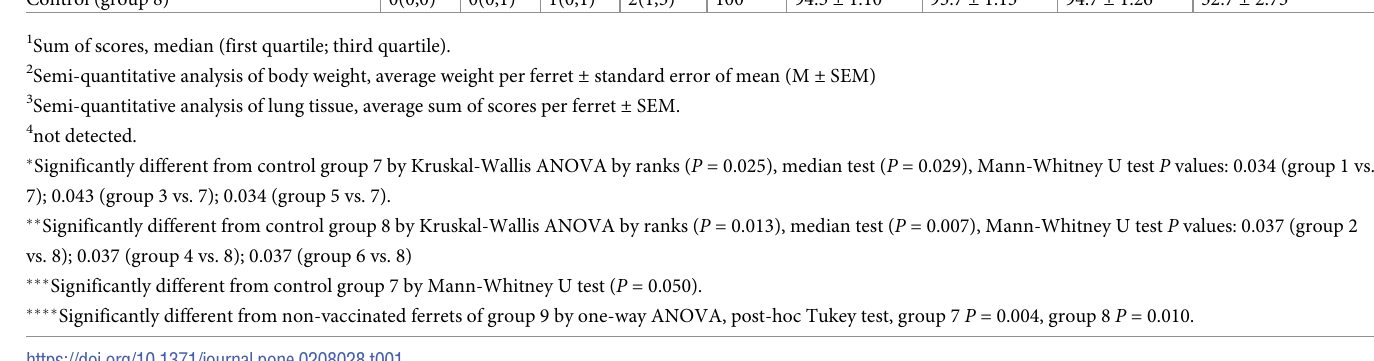
Semi-quantitative analysis of body weight, average weight per ferret ± standard error of mean (M ± SEM) 3 Semi-quantitative analysis of lung tissue, average sum of scores per ferret ± SEM. 4 not detected. � Significantly different from control group 7 by Kruskal-Wallis ANOVA by ranks ( P = 0.025), median test ( P = 0.029), Mann-Whitney U test P values: 0.034 (group 1 vs. 7); 0.043 (group 3 vs. 7); 0.034 (group 5 vs. 7). �� Significantly different from control group 8 by Kruskal-Wallis ANOVA by ranks ( P = 0.013), median test ( P = 0.007), Mann-Whitney U test P values: 0.037 (group 2 vs. 8); 0.037 (group 4 vs. 8); 0.037 (group 6 vs. 8)